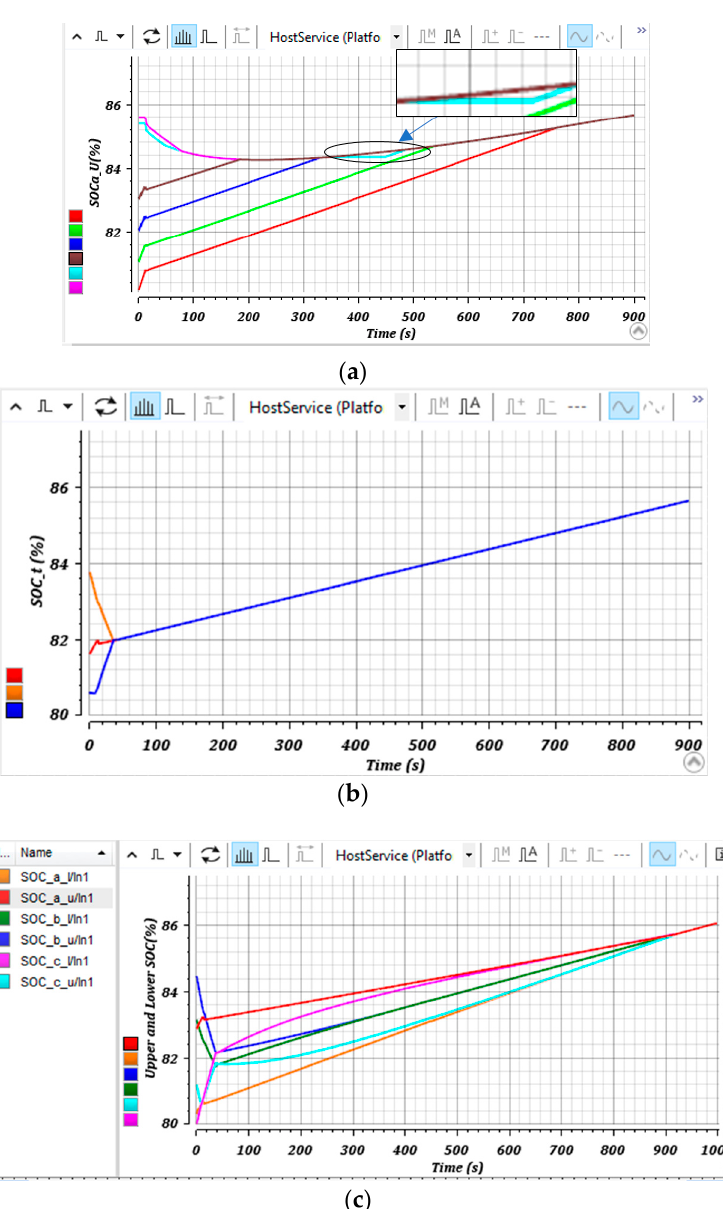
Figure 17. ( a ) Battery SOC in SMs 1, 10, 20, 30, 54, and 56; ( b ) leg average SOC; and ( c ) arm average SOC.